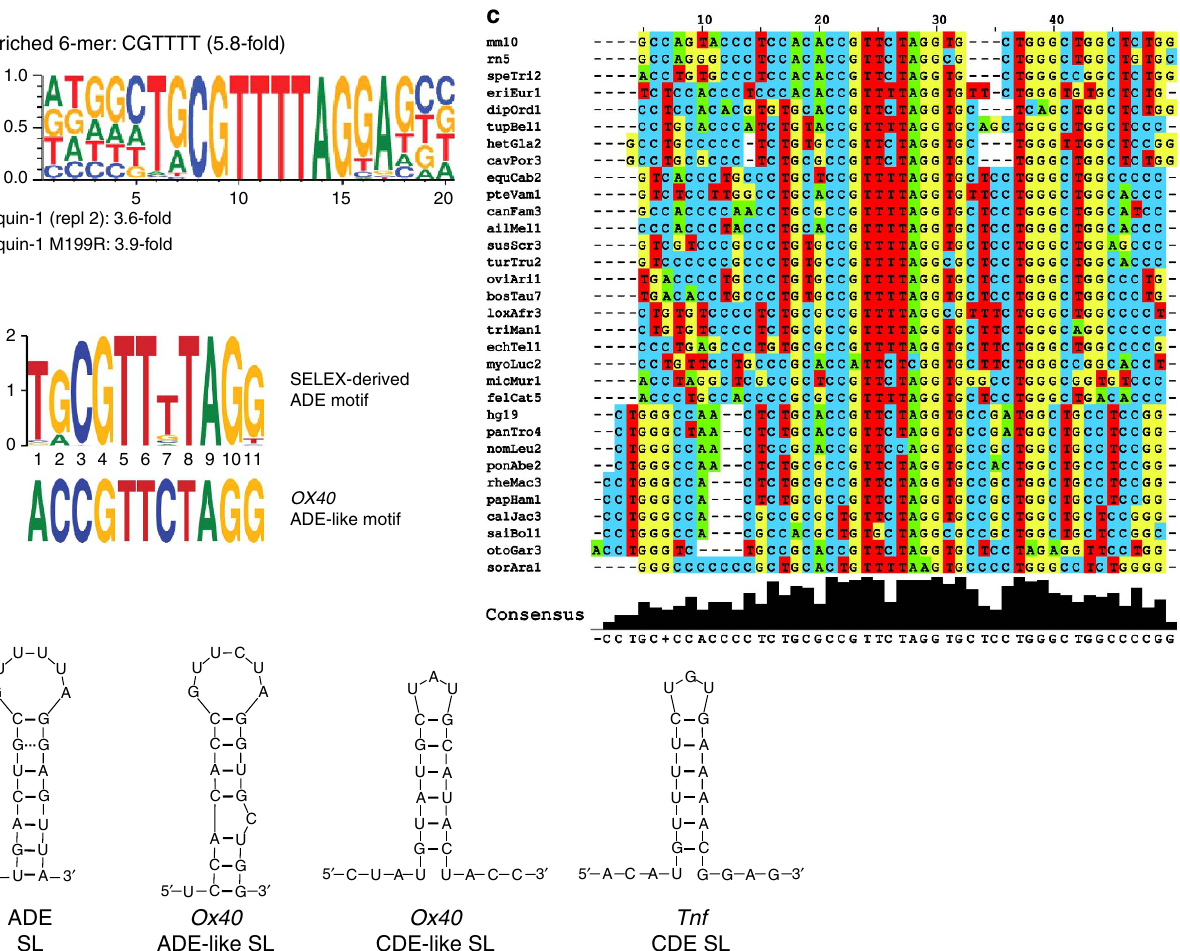
Figure 1 | SELEX identifies a novel SL RNA ligand of Roquin-1. ( a ) Enriched hexamers that were found by Roquin-1 N terminus (residues 2–440) or Roquin-1 M199R N terminus (residues 2–440) (see also Supplementary Fig. 1). ( b ) An ADE sequence motif in the Ox40 3 0 -UTR closely resembles the MEME motif found in SELEX-enriched RNA sequences. ( c ) Conservation of the motif found in Ox40 3 0 -UTRs for various species as indicated. The labels correspond to the versions of the genome assemblies in the UCSC server (see Method section). rn5 is the fifth assembly version of the rat ( Rattus novegicus ). ( d ) Schematic representation of the predicted SELEX-derived consensus SL, ADE and the Ox40 ADE-like hexaloop SL. The broken line between the G–G base pair in the ADE SL indicates a putative non-Watson–Crick pairing. The Ox40 CDE-like SL and the Tnf CDE SL are shown for comparison. See also Supplementary Fig.